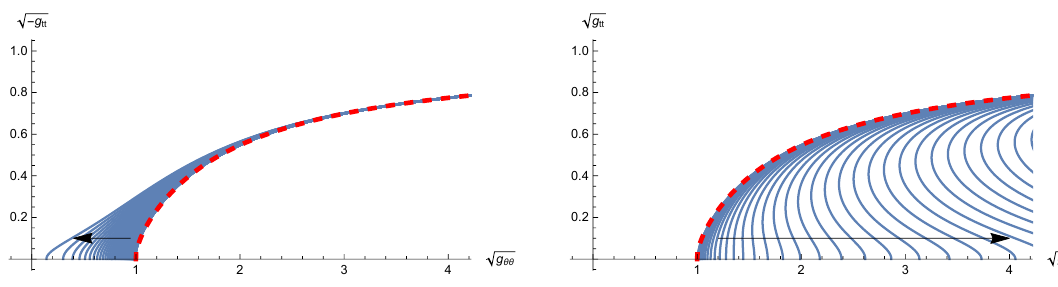
√ √ Figure 6 . Figure showing curves of − g tt plotted against g θθ at constant intervals of electric EM flow time ∆ λ and for a small initial perturbation of an electric RN solution with reasonably large charge corresponding to r − = 0 . 8 (recall r + = 1 ). The lefthand frame shows the flow where the horizon is initially reduced in size, and we see that it flows to a singularity at λ ' 3 . 9 (here ∆ λ = 0 . 05 ). The righthand frame shows the situation where the horizon is perturbed initially to be larger than that of RN, and we see it apparently expands forever (here the curves are shown for flow intervals ∆ λ = 0 . 25 ). The geometry of the RN fixed point is shown by the red dashed curve, and the arrows indicate the sense of change of the geometry for increasing flow time. Both these behaviours are qualitatively similar to the Schwarzschild fixed point under Ricci flow. We see analogous behaviour for all charges of the electric RN fixed